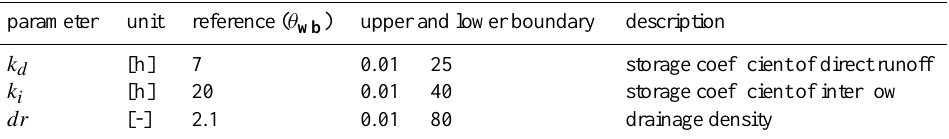
Table 3. Overview of the three used conceptual model parameters considered for calibration; the reference parameter vector θ wb was estimated in order to use WaSiM for water-balance simulations in the Rietholzbach catchment; additionally we provided the conceptual soil parameter k rec that plays a role in another case